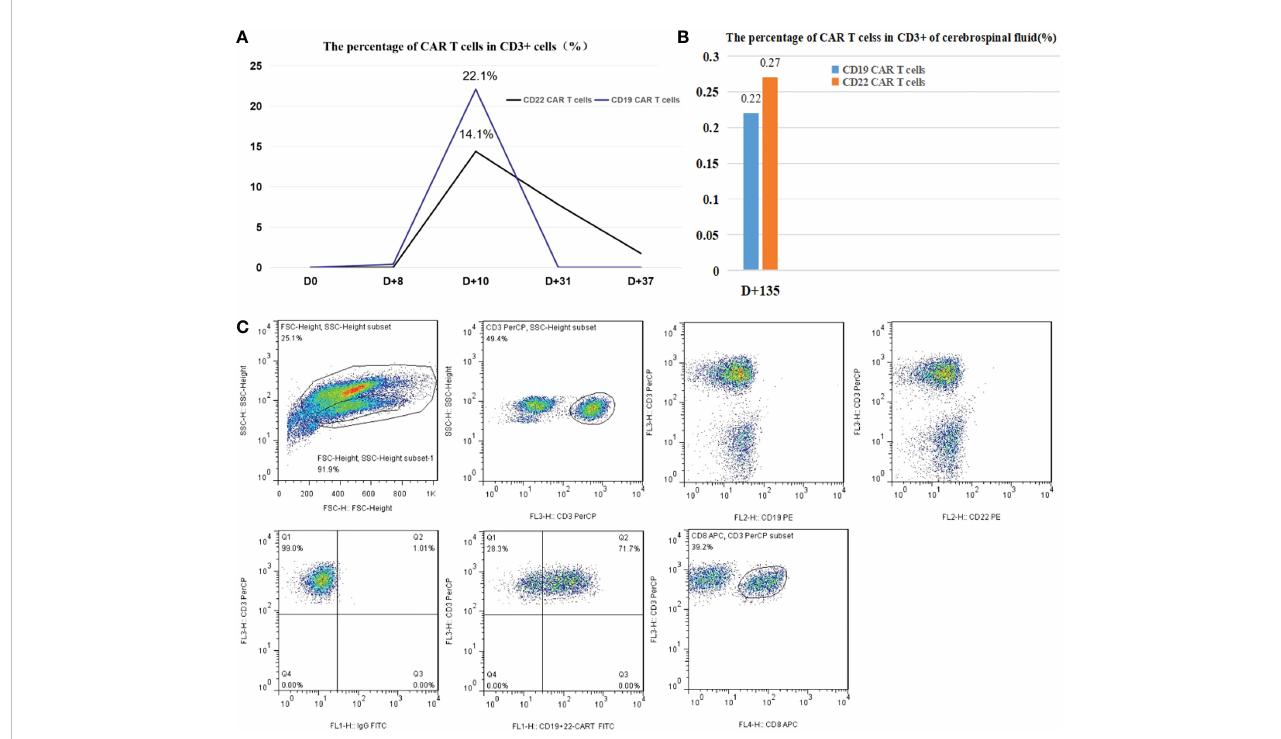
FIGURE 4 (A) The peak percentages of CAR T cells in CD3+ cells in peripheral blood were 22.1% and 14.4%, as shown. (B) On d+135, the percentages of CD19 and CD22 CAR T cells in CD3+ cells of the cerebrospinal fl uid were 0.22% and 0.27%, respectively. (C) Representative plots of the fl ow cytometry gating strategy for anti-CD19 and anti-CD22 CAR T-cell identi fi cation. The ratio of CAR T cells to CD3+ T cells was determined by fl ow cytometry using a proprietary anti-CD19 and anti-CD22 CAR-T cell-speci fi c detection reagent(Shanghai YaKe), and the monoclonal antibodies and matching reagents, such as CD3-PerCP BD SK7, CD8-APC BD SKI. CD19-PE BD 4G7, CD22-PE BD S-HCL-1, and IgG-FITC BD X40, were obtained from